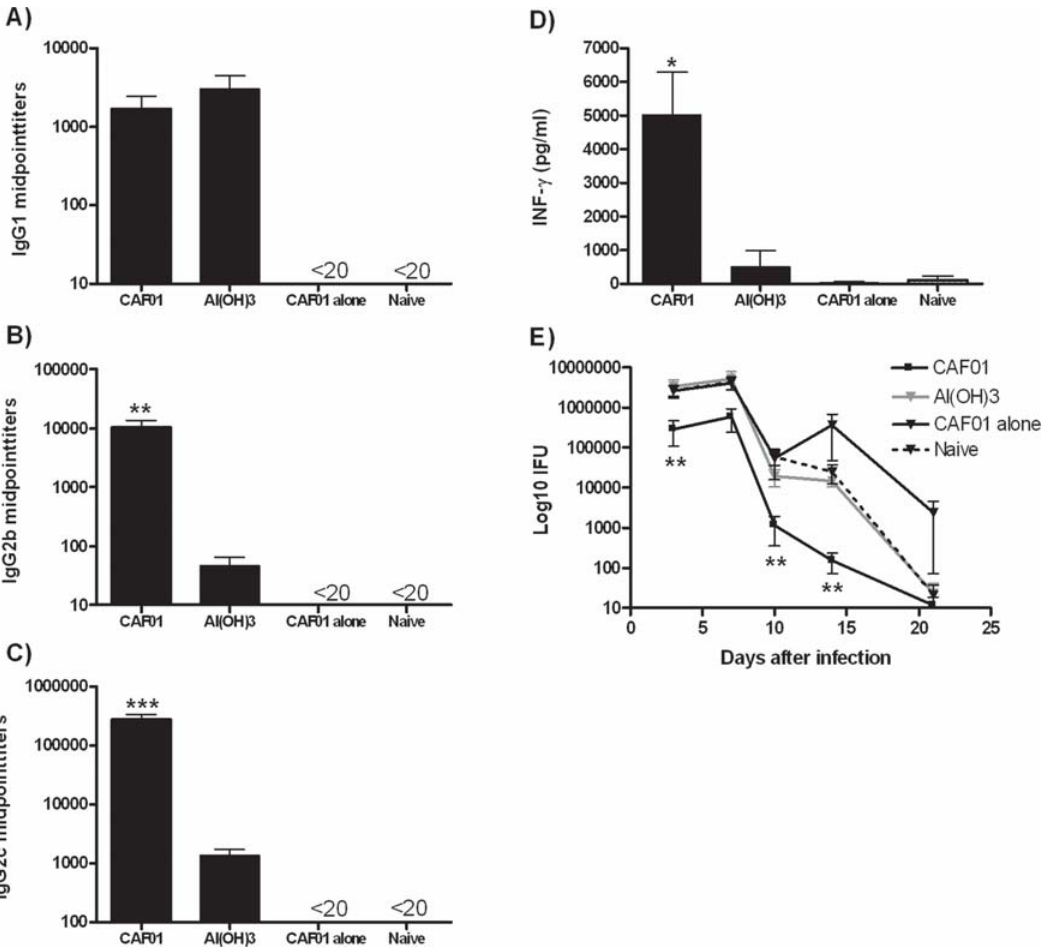
Figure 6. Immune responses and protection induced by CAF01 in a chlamydia model. C57BL/6 mice were immunized three times with 5 m g of MOMP in CAF01 or Al(OH) 3 . Three weeks after the last immunization, mice were bled by periorbital puncture and individual sera tested for MOMP A) IgG1, B) IgG2b and C) IgG2c by ELISA (n=6). D) Individual cultures of splenocytes (n=3–6) were harvested at the same time point and re- stimulated in vitro with 5 m g of MOMP. The release of IFN- c was determined by ELISA. E) Six weeks after the last immunization, mice